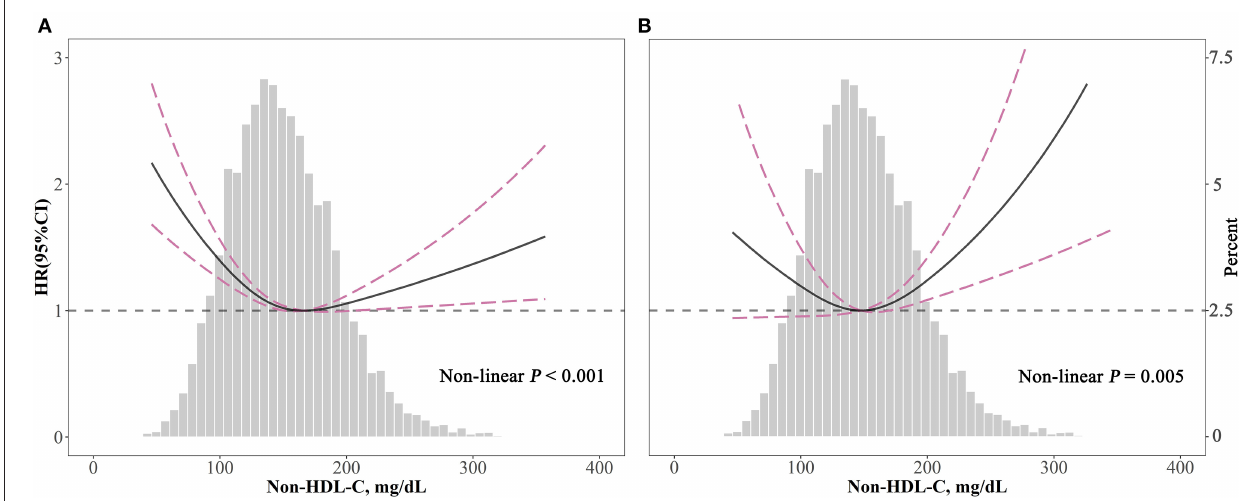
FIGURE 3 | Spline analyses of all-cause (A) and cardiovascular (B) mortality by non-HDL-C in the overall cohort and the probability distribution histogram is represented in the background [spline analyses were adjusted for age, gender, race, smoking, body mass index, systolic blood pressure, diabetes, and medicine use (antihypertensive drugs, hypoglycemic agents, and lipid-lowering drugs)].